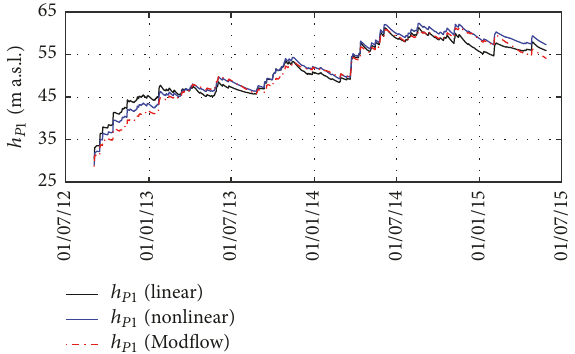
Figure 12: Results of the piezometer 𝑃1 groundwater level hydrograph (applied coefficients 𝑘 𝑥,𝑦,𝑧 , 𝑛